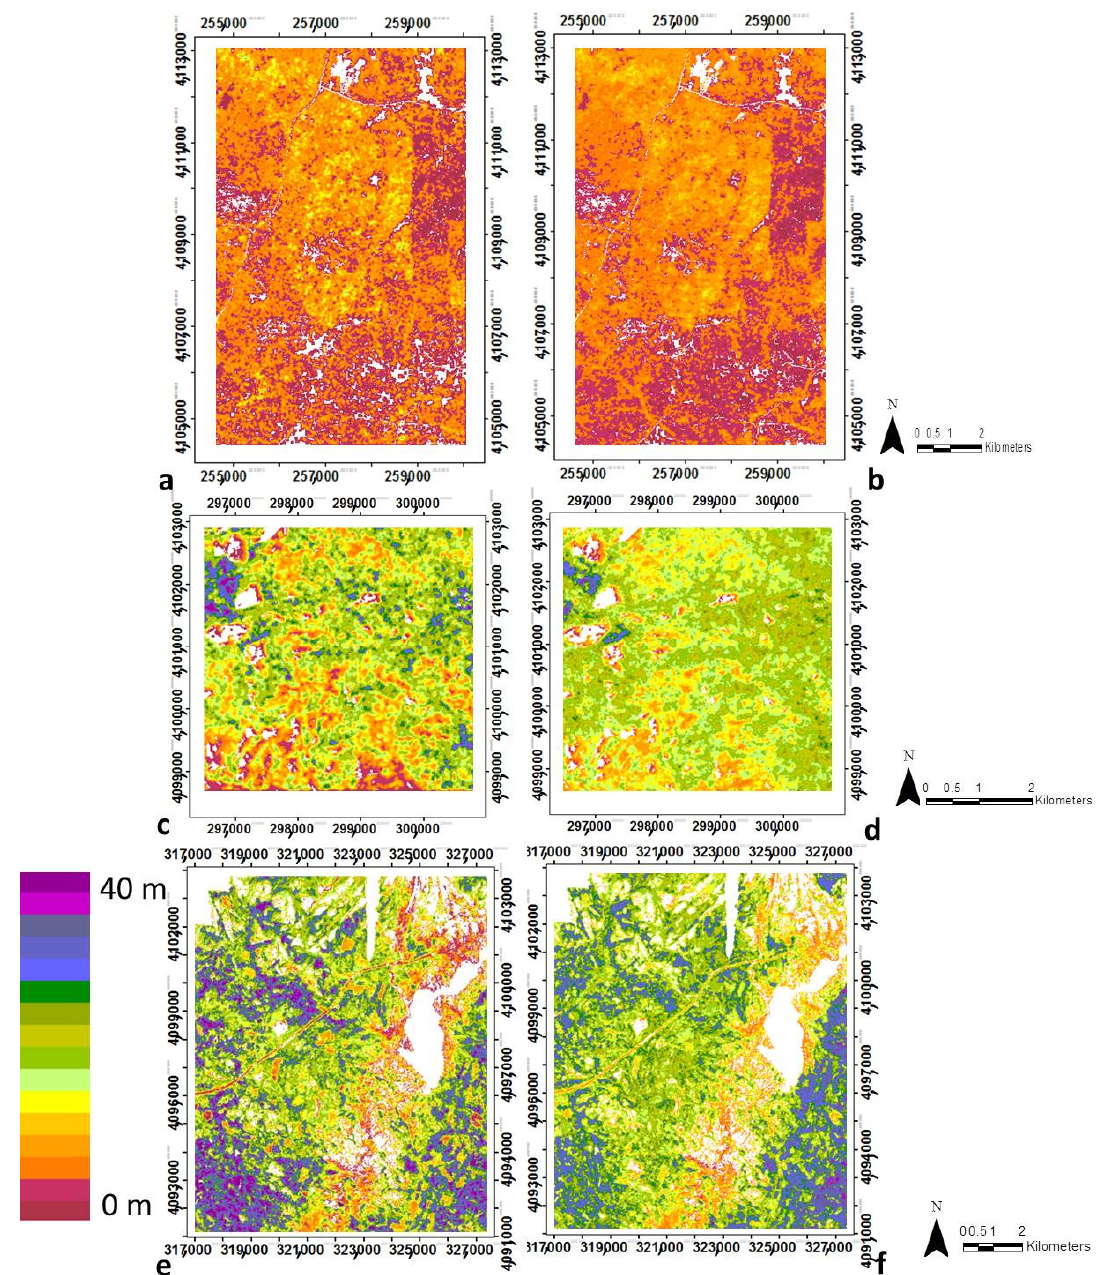
Figure 4. Spatial distribution of canopy height from LiDAR-derived data ( a , c , e ) and from Random Forests regression using optical metrics ( b , d , f ), for SJER ( a , b ), SOAP ( c , d ) and TEAK ( e , f ). White areas are non-vegetated, either water bodies, rock, bare ground, etc. Note regions are not to scale due to optimizing images and site size differences. See Supplementary Materials, Table S5 for the ranking of the input metrics.